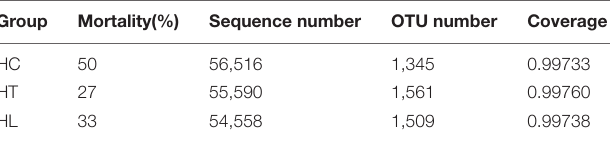
TABLE 2 | Mortality and sequence number based on operational taxonomic unit (OTU) levels in crucian